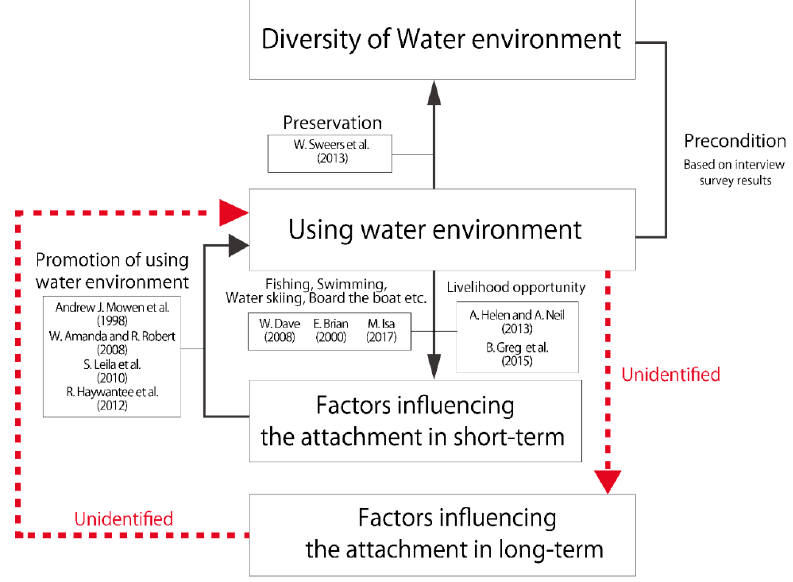
Figure 2. Theoretical framework.